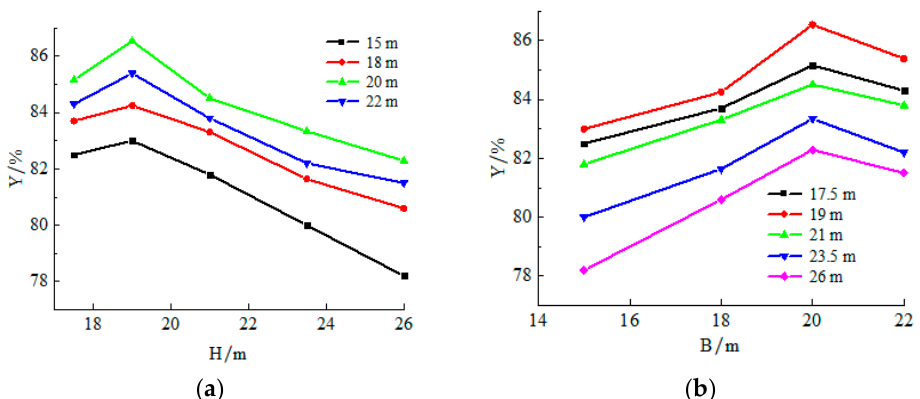
Figure 5. Relationship of the difference between recovery and dilution ratio Y and sublevel height H and production drift spacing B: ( a ) relationship curve of sublevel height H and the difference between recovery and dilution ratio Y; ( b ) relationship curve of production drift spacing B and the difference between recovery and dilution ratio Y.